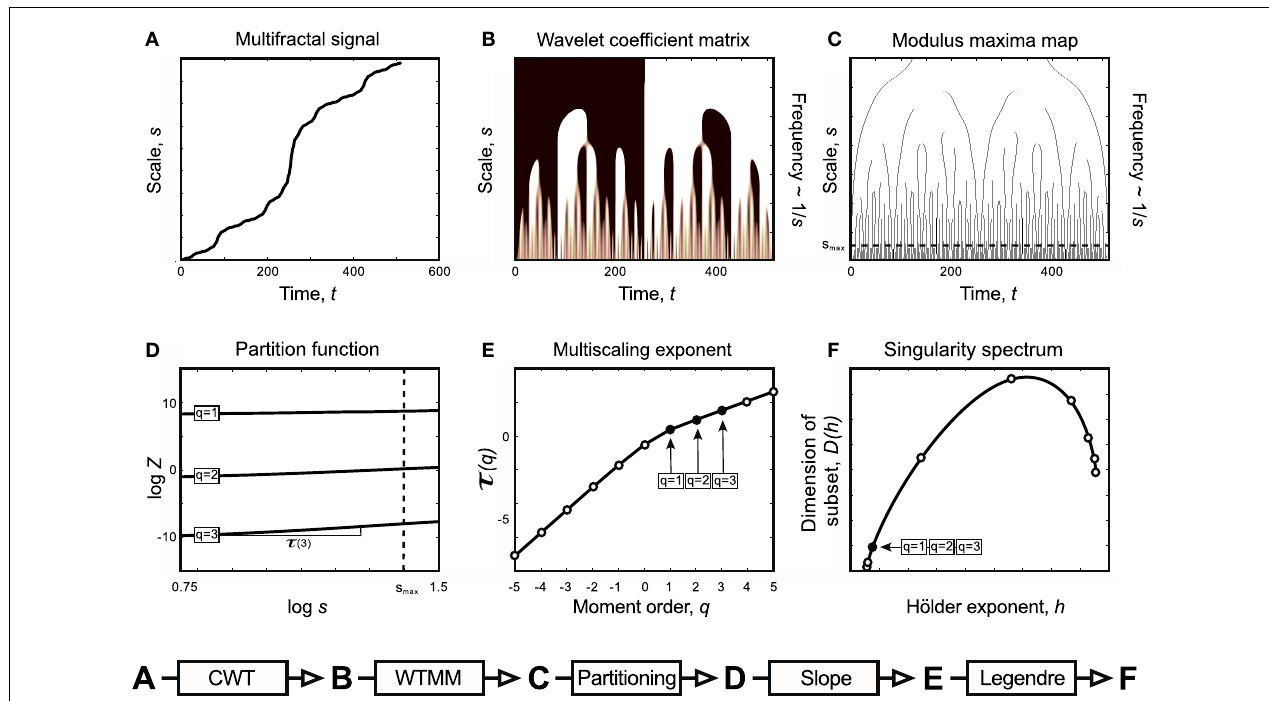
FIGURE 5 | Relations of ContinuousWaveletTransform operation, WaveletTransform Modulus Maxima method, and multifractal formalism to obtain singularity spectrum of an ideal multifractal. Devil’s staircase with weight factors p 1 = p 3 = 0.2, p 2 = 0.6 was used to model an ideal multifractal time series (A) .The wavelet coefficient matrix (B) is obtained by continuous wavelet transform in the time-scale space. Modulus maxima map (C) containing the maxima lines across the scales defined by CWT.We call modulus maximum of the wavelet transform |W ψ [ X ]( t , s 0 )|; any point ( t 0 , s 0 ), which corresponds to a local maximum of the modulus of |W ψ [ X ]( t , s 0 )| is considered as a function of t . For a given scale, it means that | W ψ [ X ]( t 0 , s 0 )| > | W ψ [ X ]( t , s 0 )| for all t in the neighborhood right of t 0 , and | W ψ [ X ]( t 0 ,